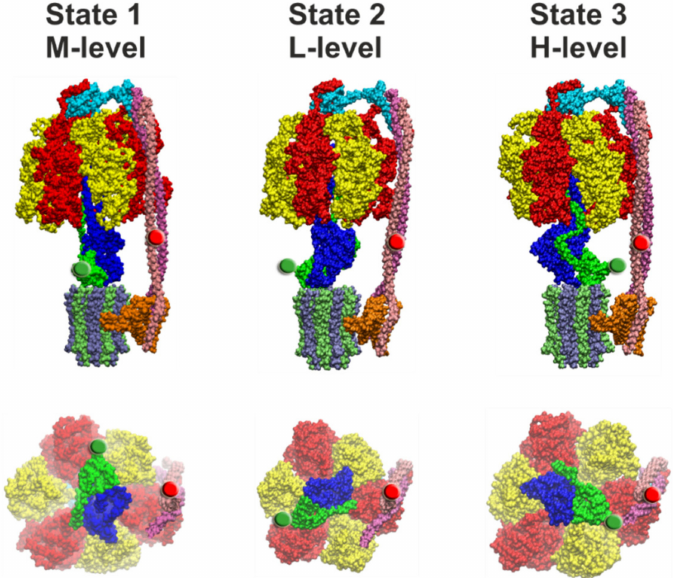
Figure 6. Side view (top row) and view from the membrane side with the c -ring and subunit a omitted of the three cryo-EM structural states of EcF O F 1 [12]. State 1 (PDB-id: 5T4O, left), state 2 (PDB-id: 5T4P, middle), and state 3 (PDB-id: 5T4Q, right) correspond to FRET levels M, L, and H, respectively (as in Figure 4). In each image, the FRET-donor position at ε 56 is marked with a green sphere and the FRET-acceptor position at b 64 is marked with a red sphere. The portions of subunit ε and γ that extends beyond the diameter of the c -ring must pass through the narrow gap created by the peripheral stalk during rotation from state 3 to state 1, and during rotation from state 1 to state 2, respectively. The subunit coloring is the same as in Figure